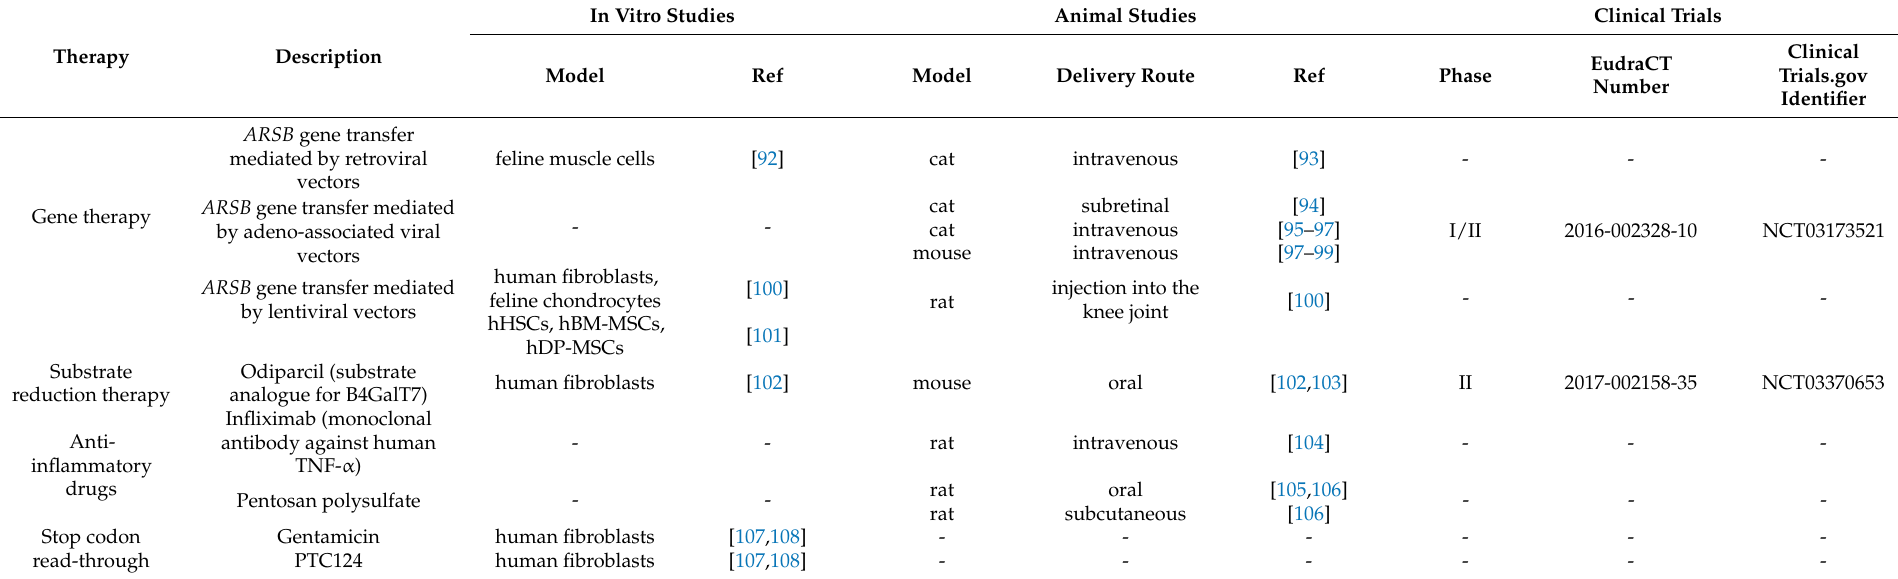
Table 1. Experimental therapies evaluated for the treatment of MPS VI. hHSCs = human hematopoietic stem cells, hBM-MSCs = human bone marrow-derived mesenchymal stem